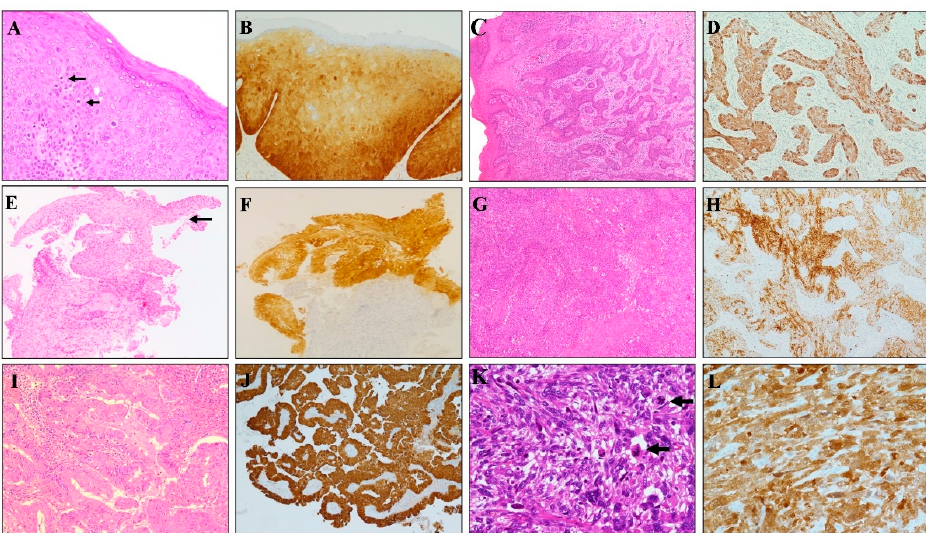
Figure 1. Diagnostic applications of p16 INK4a (BC42 clone) in different gynecological tumors. ( A ) Vulvar intraepithelial neoplasia (high-grade SIL/VIN 3) is characterized by full-thickness nuclear atypia and increased mitotic activity (arrows). ( B ) A continuous strong nuclear and cytoplasmic p16 staining across all epithelial layers is observed. ( C ) HPV-related invasive squamous cell carcinoma of the vulva showing diffuse and strong p16 (BC42) staining ( D ). ( E ) Cervical bioptic specimen showing high-grade dysplasia of the surface epithelium (arrow) confirmed by the strong nuclear and cytoplas- mic staining for p16 ( F ). ( G ) HPV-related invasive squamous cell carcinoma of the uterine cervix showing diffuse and strong p16 (BC42) staining ( H ). ( I ) HPV-related invasive adenocarcinoma of the uterine cervix showing diffuse and strong p16 (BC42) staining ( J ). ( K ) Uterine spindle cell leiomyosarcoma is characterized by high-grade nuclear atypia and in- creased mitotic activity (arrows). ( L ) A strong nuclear and cytoplasmic p16 staining is observed.